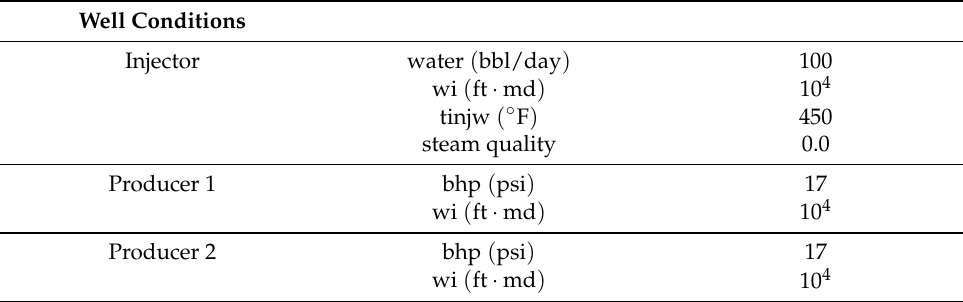
Table 4. Well data for Example 1.